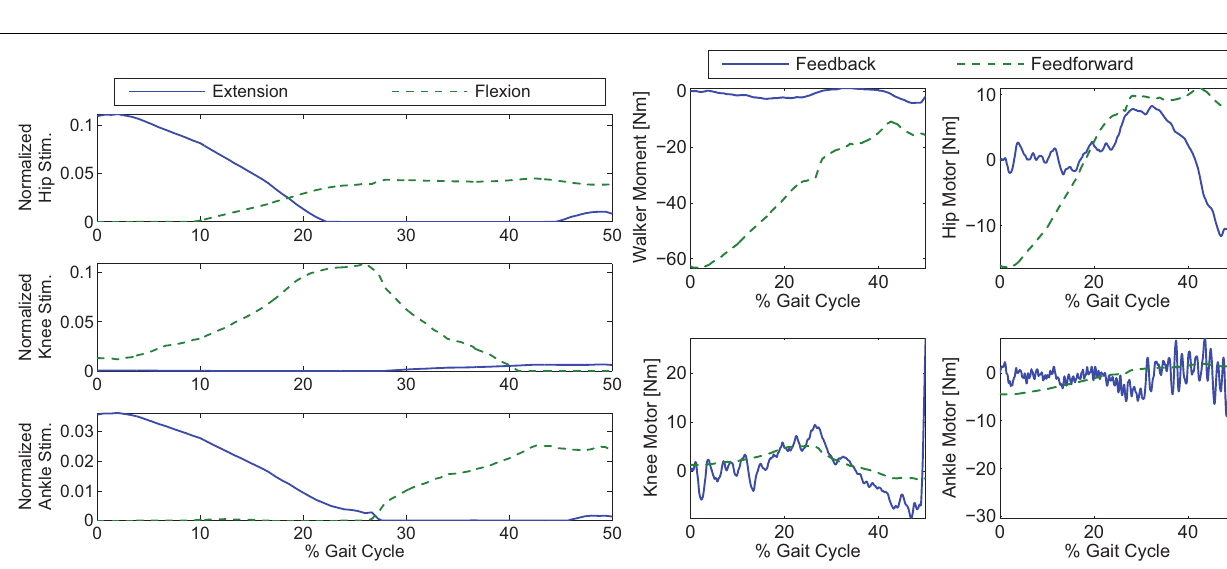
component and a feedback component to the synergy